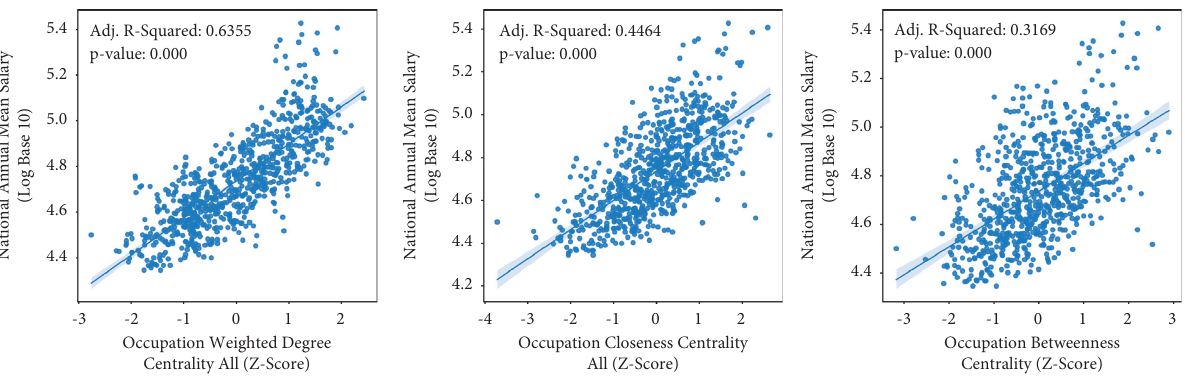
Figure 5: Occupational skill centrality versus national annual mean salary.